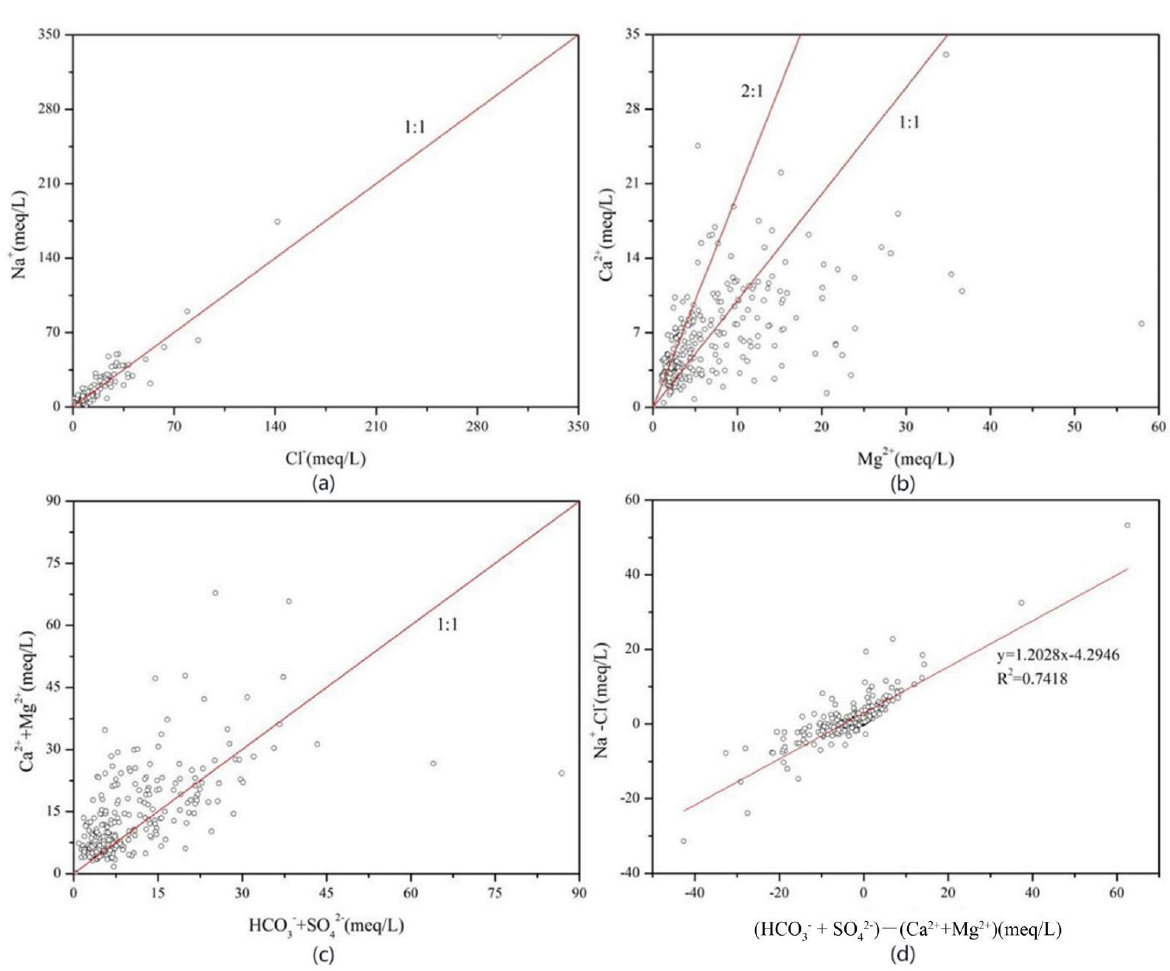
Figure 5. Relationships between ( a ) Na + /Cl − , ( b ) Ca 2+ /Mg 2+ , ( c ) Ca 2+ /Mg 2+ versus HCO 3 − /SO 4 2 − , and ( d ) Ca 2+ /Mg 2+ — HCO 3 − /SO 42 − versus Na + /Cl − in the groundwater of the Chahannur Basin. The ratio of the concentration of Ca 2+ to that of Mg 2+ can reflect the dissolution of carbonate minerals such as calcite and dolomite. If the ratio is close to 1, it indicates that dolomite has dissolved to a large extent. If the ratio increases, it may be because of calcite dissolution. When the ratio is greater than 2, it indicates silicate mineral dissolution. The diagram of the relationship between Ca 2+ and Mg 2+ in groundwater samples (Figure 5b) shows that a small part of the groundwater samples is located above the 2:1 line, indicat- ing that Ca 2+ and Mg 2+ in the groundwater partly originate from the dissolution of silicate minerals; furthermore, most of the samples are located above the 1:1 line, indicating that Ca 2+ and Mg 2+ in groundwater are mainly derived from the dissolution of carbonate min- erals such as dolomite and calcite. The ratio of c(Ca 2+ + Mg 2+ )/c(HCO 3 − + SO 42 − ) was used to characterize the dissolution of carbonate minerals and sulfate minerals in the groundwater system. As shown in Fig- ure 5c, the sample points are mainly located near the 1:1 line, indicating both carbonate dissolution and silicate dissolution. At the same time, the ratio of the sample points is slightly offset on the 1:1 line, indicating that the SO 4 2− sources and the Ca 2+ and Mg 2+ sources are slightly different. Sulfate may originate from the participation of sulfuric acid in the dissolution of carbonate rocks and the dissolution of gypsum. Most of the sample